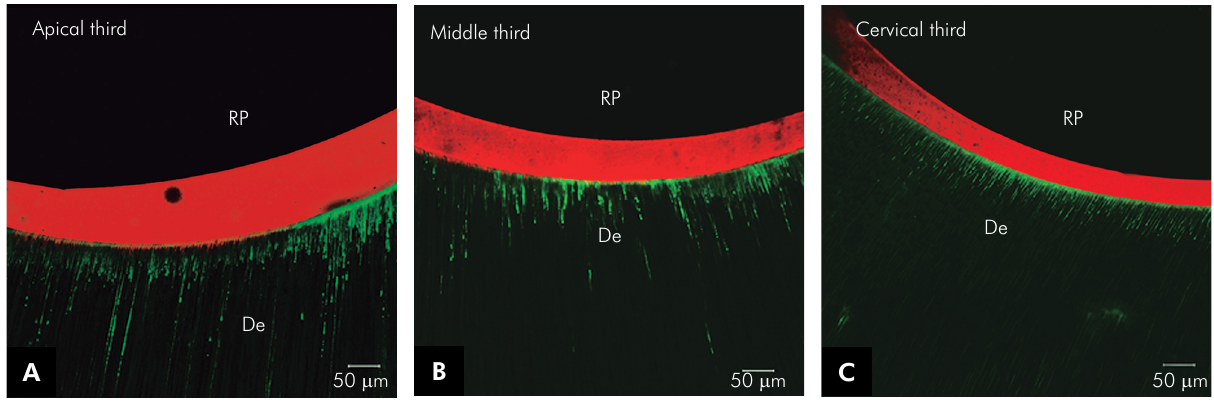
Figure 1. CLSM images (20x) of the interface between relined fiberglass post and root dentin using RelyX ARC (1A, 1B, 1C). Green color: Adper Scotchbond Multi-Purpose Plus Adhesive (activator, primer and catalyst). Red color: resin cement RelyX ARC. The resin cement thickness decreases from the apical third to the cervical third. De: Dentin; RP: Relined fiberglass post.